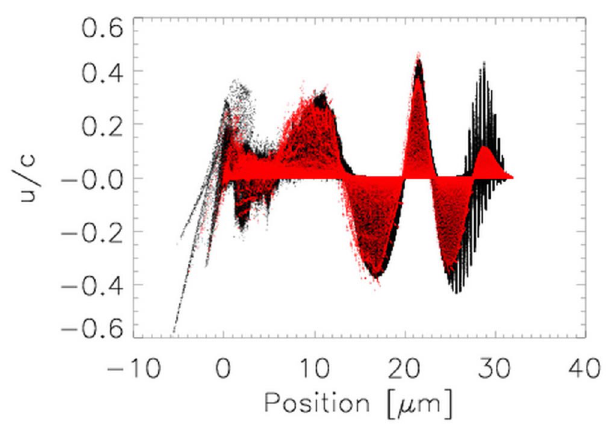
FIG. 6. (Color) Longitudinal electron phase space, computed with full PIC (black) and with the envelope model